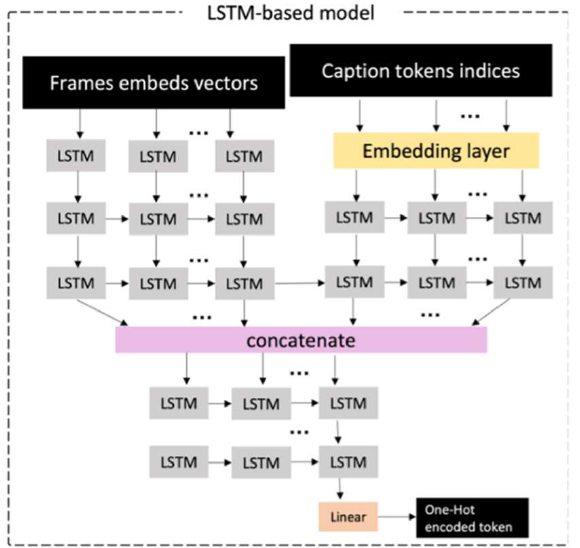
Figure 6. The LSTM-based model architecture.